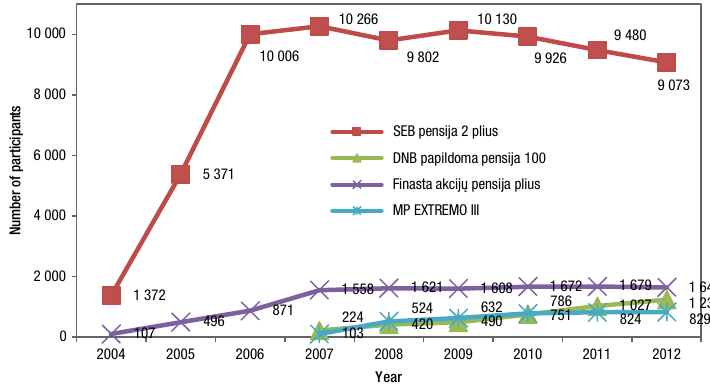
Fig. 8. Change of equity 3 rd pillar PF participants during 2004–2012 Source : created by authors according to annual reports of